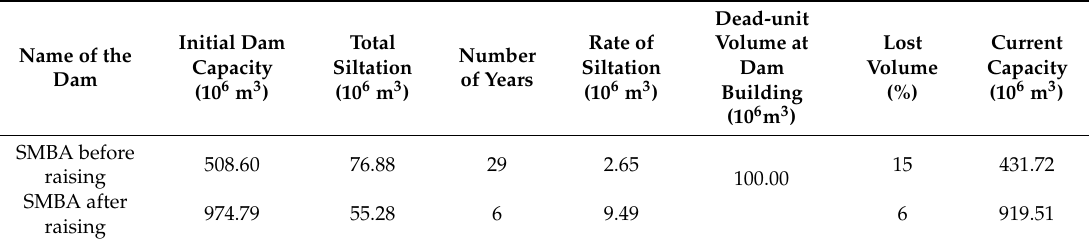
Table 5. Summary of SMBA dam siltation calculation results since its